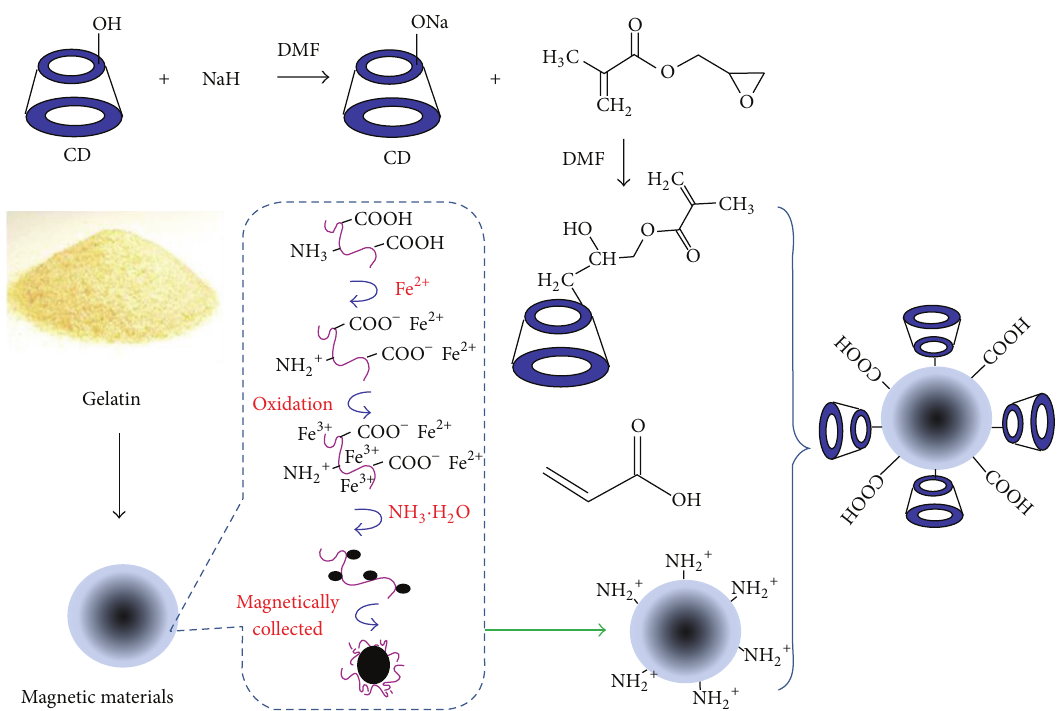
Figure 1: The schematic illustration of the preparation of magnetic